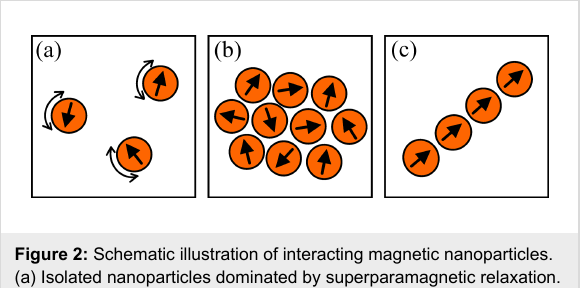
Figure 2: Schematic illustration of interacting magnetic nanoparticles. (a) Isolated nanoparticles dominated by superparamagnetic relaxation. (b) Interacting nanoparticles forming a dipole glass. (c) Nanoparticles forming a chain with aligned dipole moments.